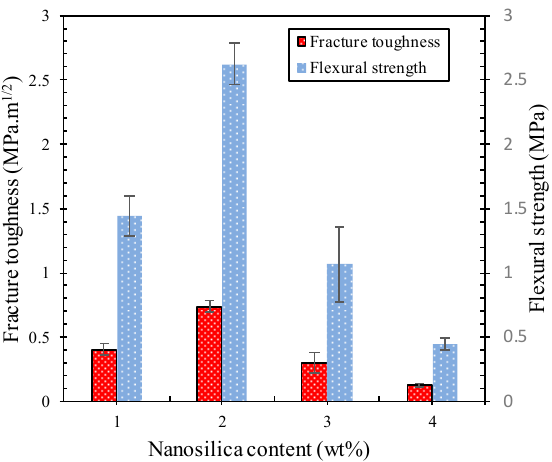
Figure 8. Fracture toughness and flexural strength of geopolymer pasta as a function of nanosilica content.